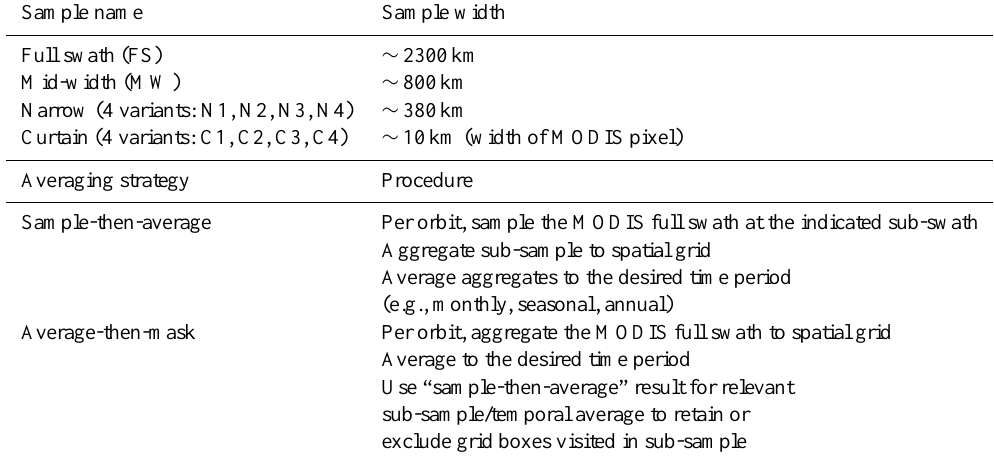
Table 1. Summary of spatial sampling strategies illustrated in Fig. 2 and summary of temporal averaging